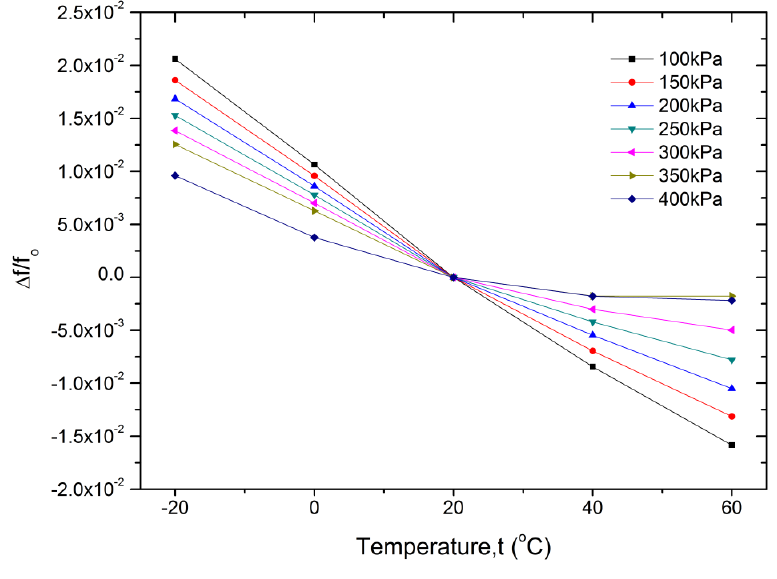
Figure 14. Temperature characteristics of the resonant pressure sensor at different applied